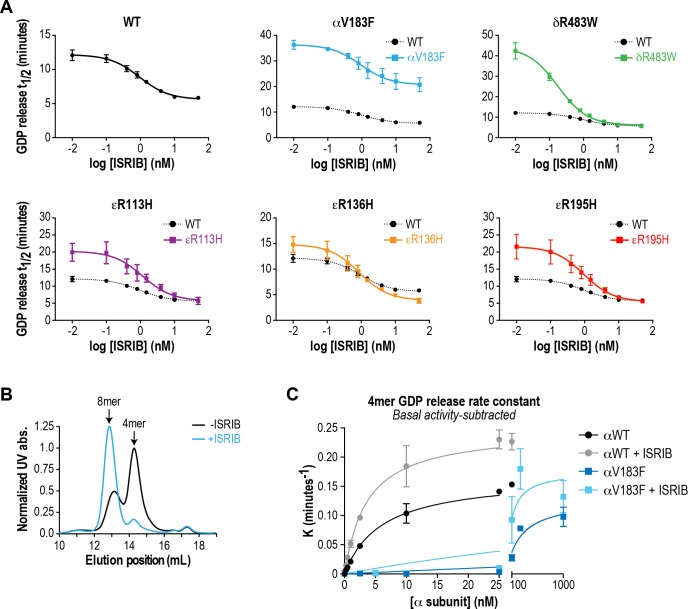
Recombinant eIF2B VWMD mutants have reduced GEF activity that is rescued by ISRIB.(A) All eIF2B VWMD mutant complexes except εR136H have reduced GEF activity compared to WT. ISRIB dose-response curves of GDP release half-life for each mutant. Half-lives of GDP release at each ISRIB concentration were calculated by fitting single-exponential decays to the Bodipy-FL-GDP fluorescence decay curves. Data from the WT curve is reproduced in each of the VWMD mutant plots as a dotted line for comparison. The ISRIB EC50 values were similar between WT and VWMD eIF2B. Each point represents 9 measurements from three independent experiments (mean ± SD). (B) ISRIB stabilizes an octameric form of eIF2B in the absence of eIF2Bα. Size-exclusion chromatograms of wild-type eIF2B tetramers (no α subunit) in the presence of 300 mM NaCl. The elution positions of the (βδγε)2 8mer and βδγε 4mer are indicated. (C) Michaelis-Menten curves of GDP release rate constants in the presence of increasing amounts of WT or V183F α subunit. WT dimeric α subunit is ~40X better at stimulating GEF activity (Km = 6 nM) compared to the monomeric V183F VWMD mutation (Km = 246 nM). ISRIB synergizes with α subunit, reducing the amounts required for GEF activity stimulation (Km = 3.6 nM for αWT and 88 nM for αV183F). Each point represents 9 measurements from three independent experiments (mean ± SD).